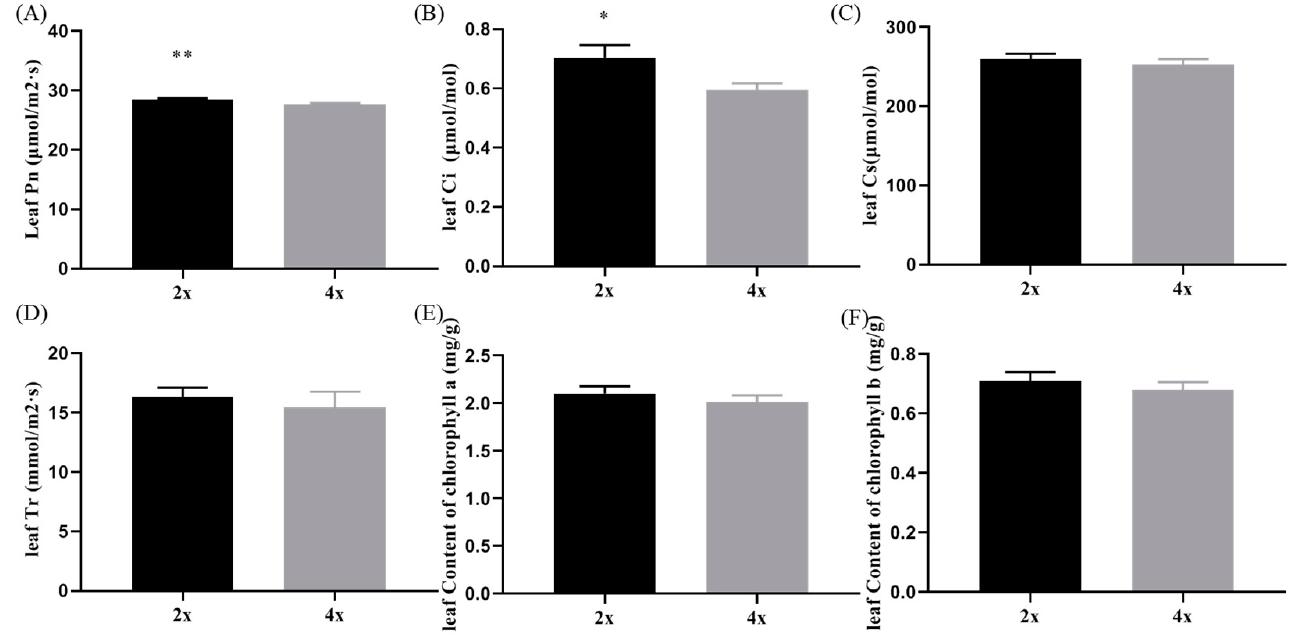
Figure 3. Comparison of photosynthetic parameters in diploid and tetraploid watermelon: ( A ) Pn;